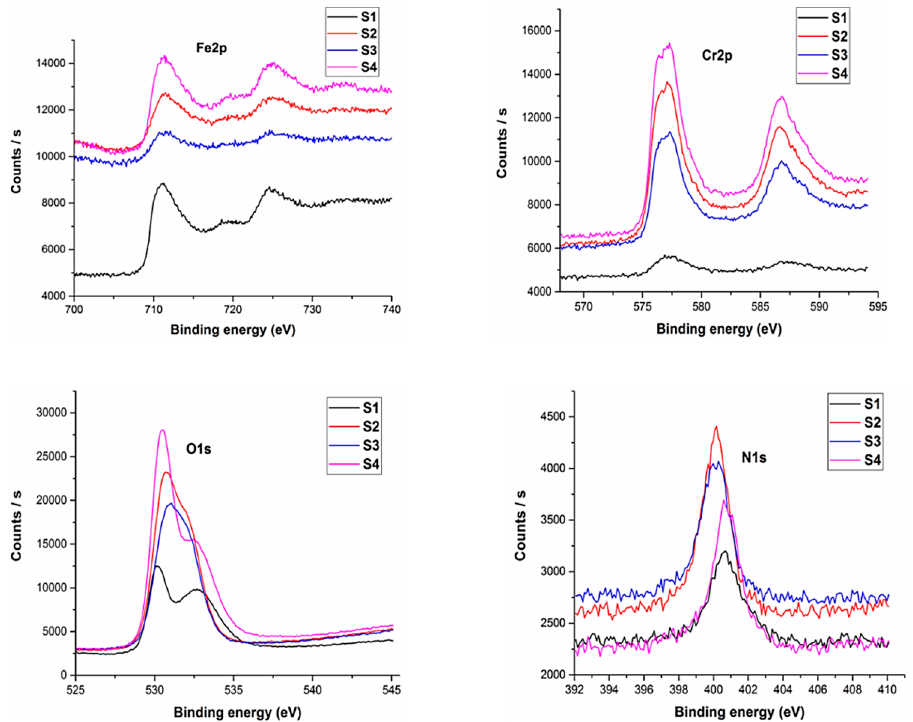
Figure 9. XPS analysis of sintered samples.